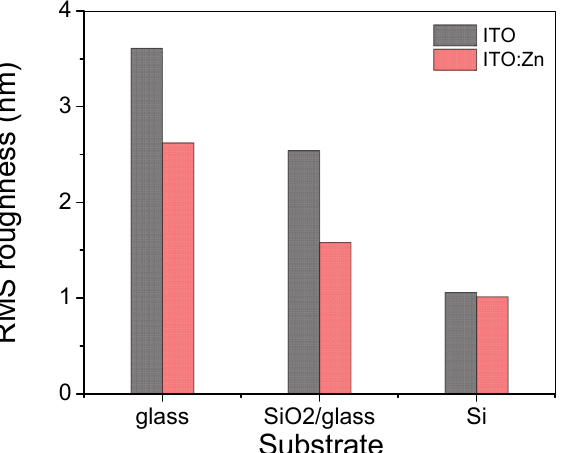
Figure 7. RMS roughness of ITO films before and after Zn doping, as a function of the substrate used: glass, SiO 2 /glass, and Si.